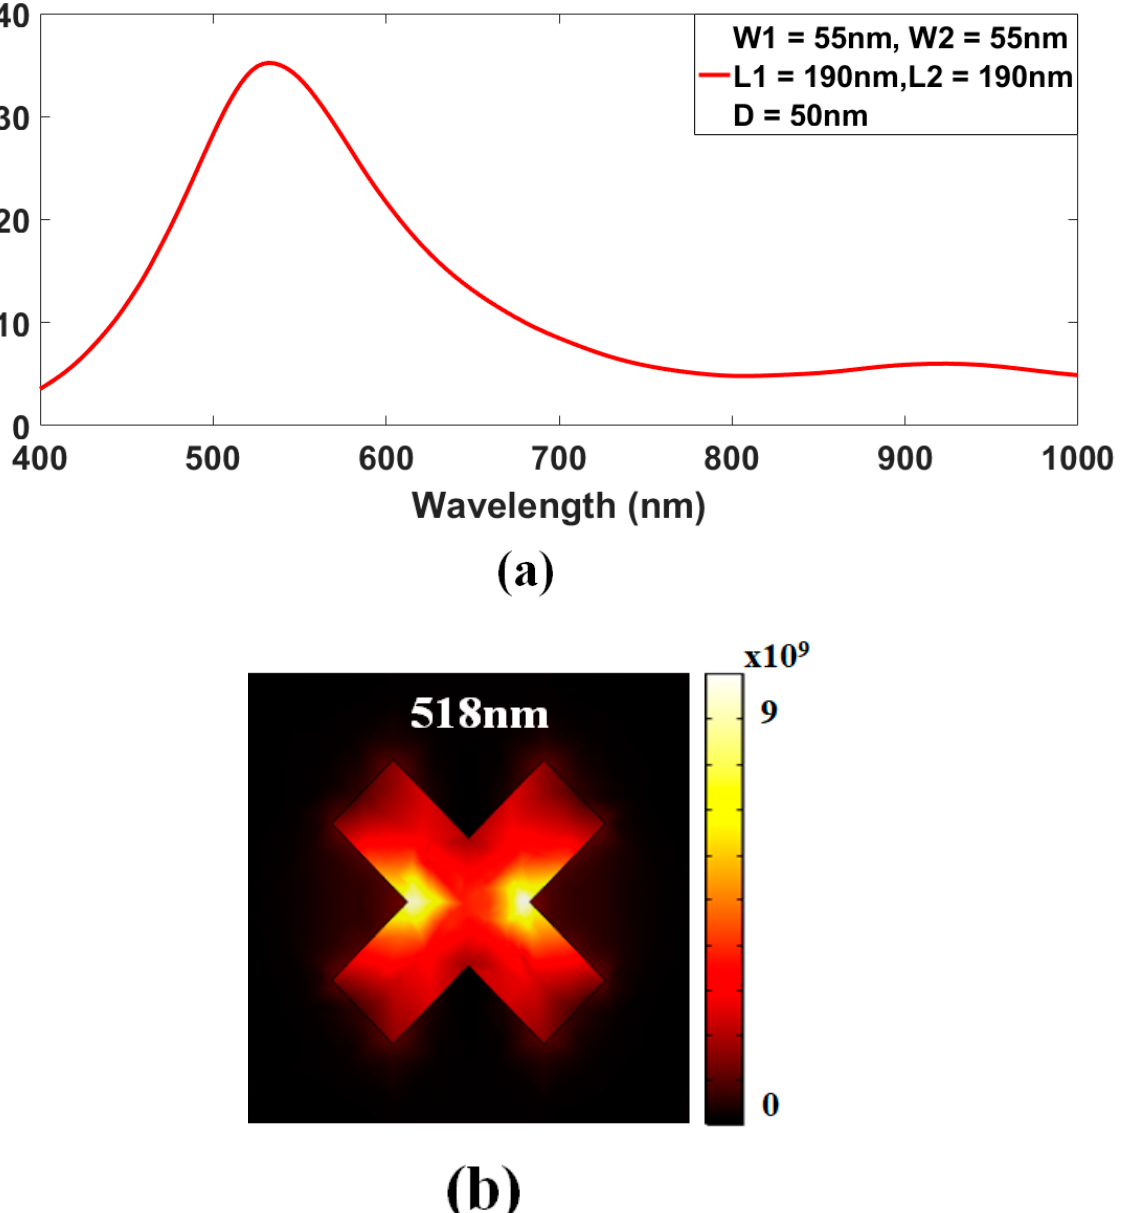
Figure 3. ( a ) Calculated transmission spectra for initial EOT PCF; ( b ) electric field distribution at resonant peak.